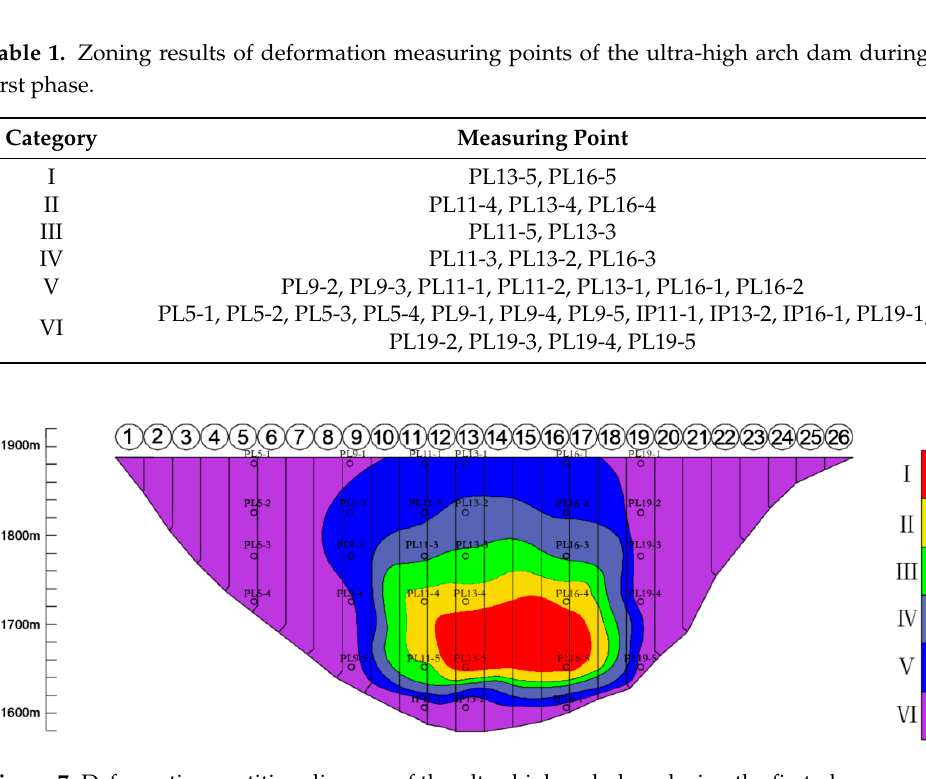
Figure 7. Deformation partition diagram of the ultra-high arch dam during the first phase.